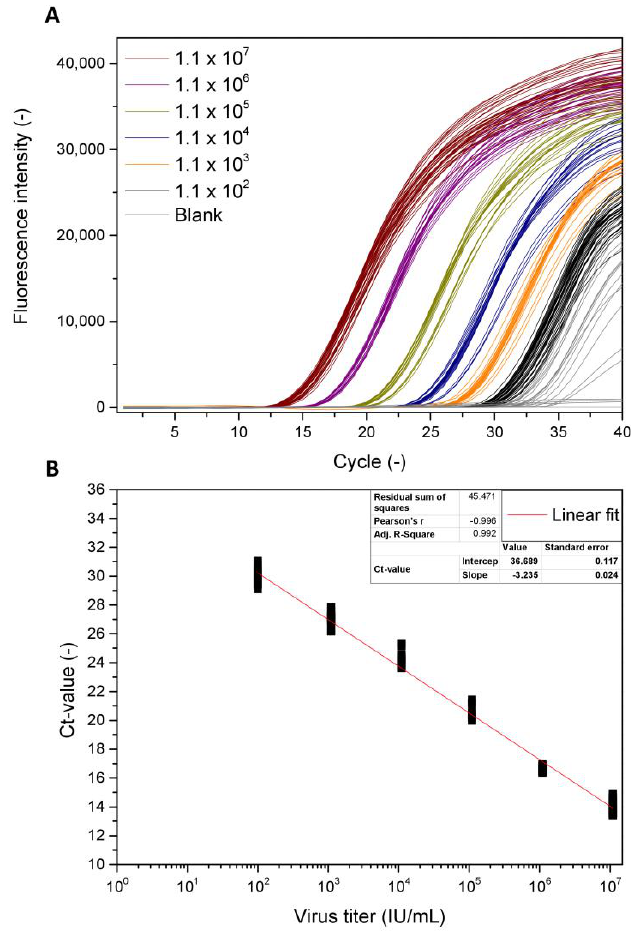
Figure 1. Amplification plots for the qPCR evaluation of different baculovirus concentrations in the range of 0 (i.e., blank)−1.1 × 10 7 IU/mL ( A ) as well as the linear regression over the concentration range ( B ). The number of replicate measurements was n = 39 for 1.1 × 10 2 IU/mL and 1.1 × 10 7 IU/mL and n = 18 for all other concentrations and the blank.